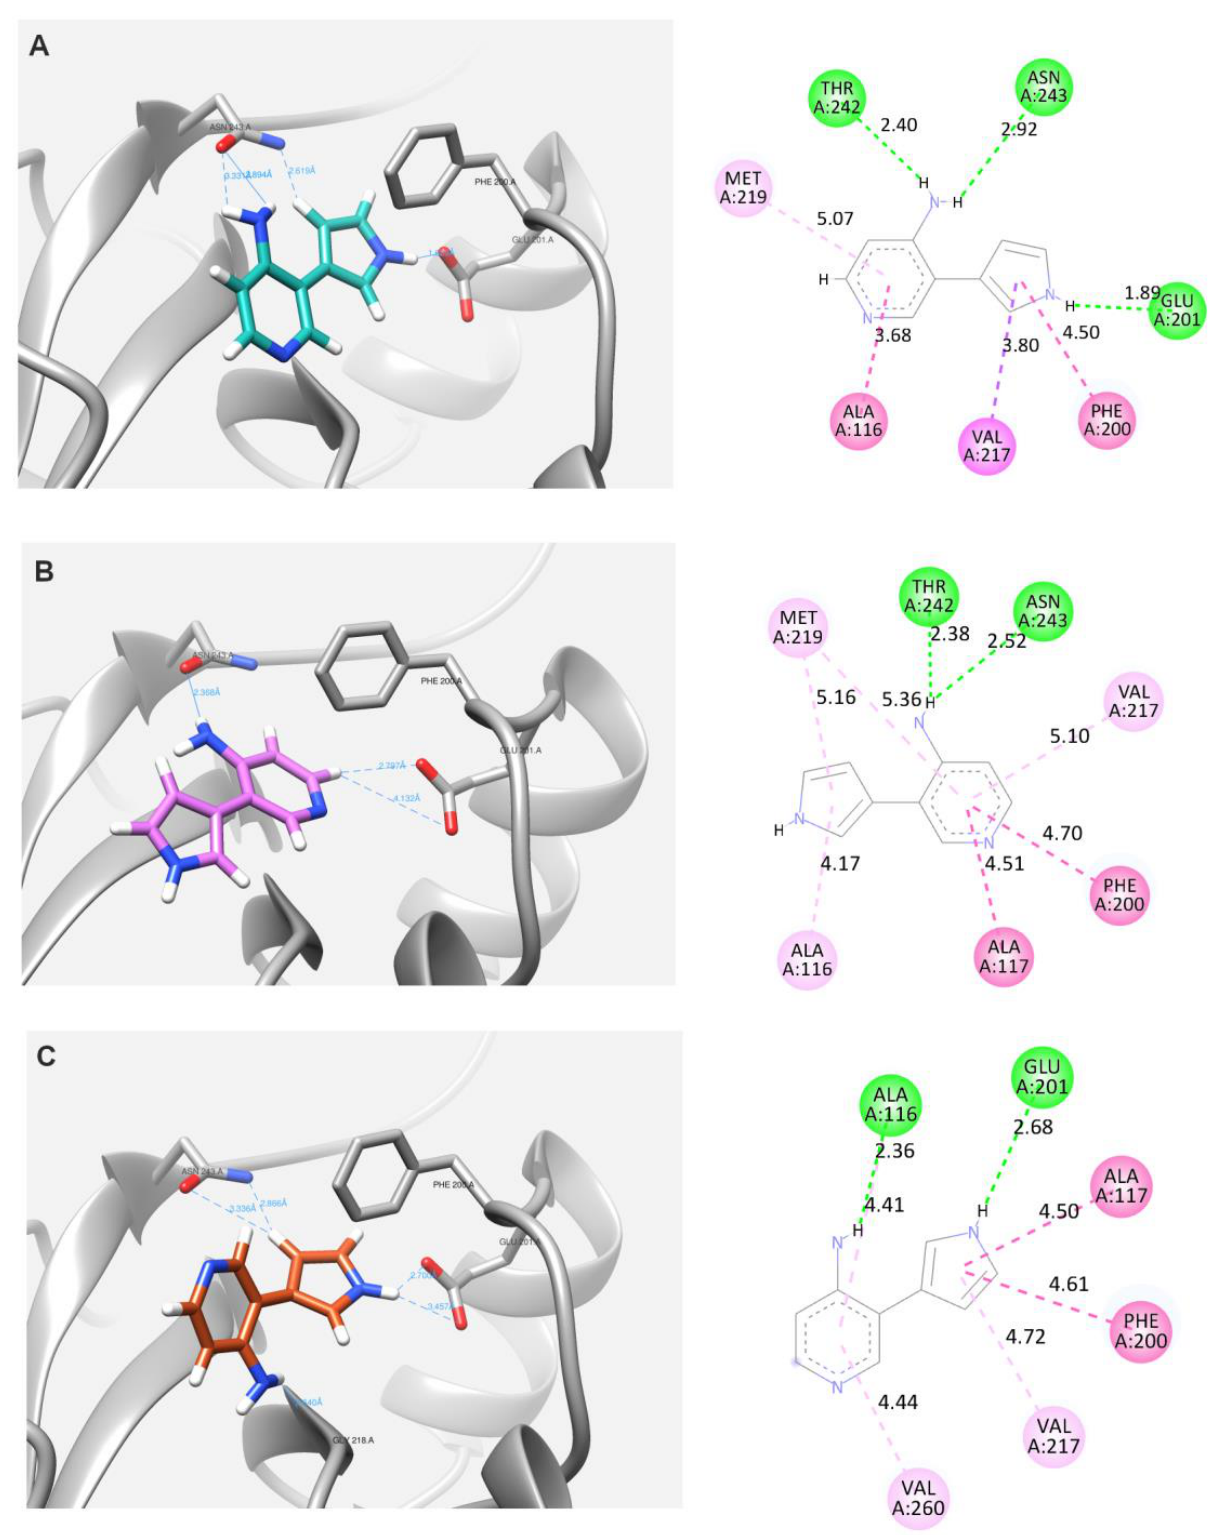
Figure 2. Docking results of flex-base 2 with 3INY with protein – ligand interaction 2D maps (bond lengths in angstroms). Models ( A – C ) are the most energetically favorable docking results (see Table